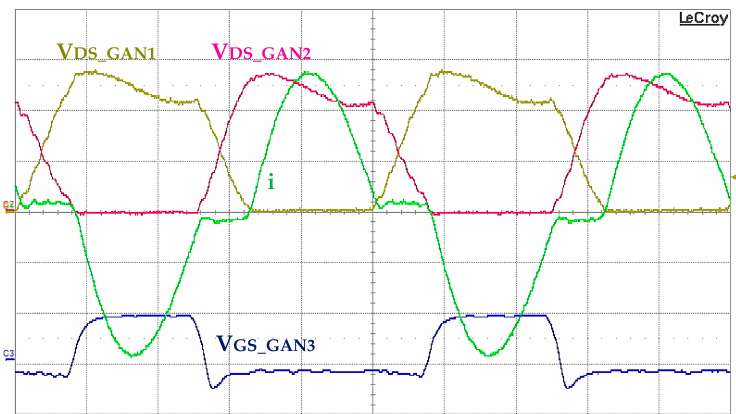
Figure 15. Drive circuit solution to provide negative voltage during the gap time.